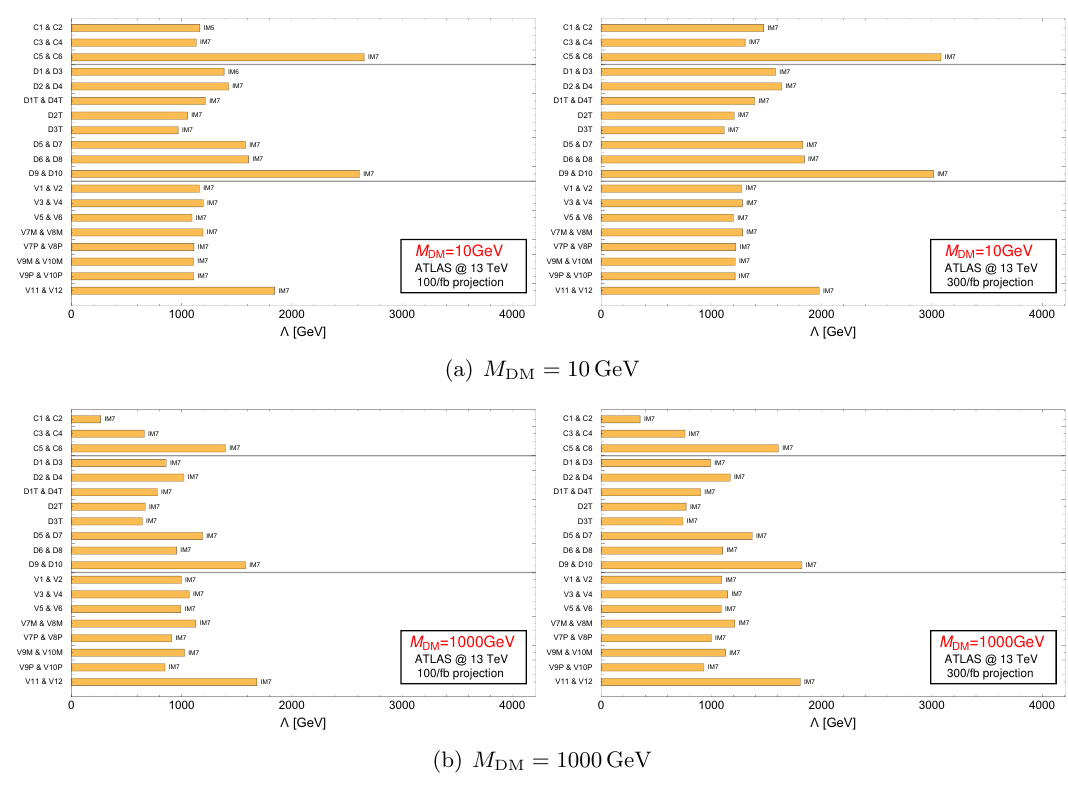
Figure 15 . Expected limits on the UV cut-o(cid:11) (cid:3) considering the selection of the ATLAS search of ref. [3] and rescaling to luminosities of 100 fb (cid:0) 1 (left panels) and 300 fb (cid:0) 1 (right